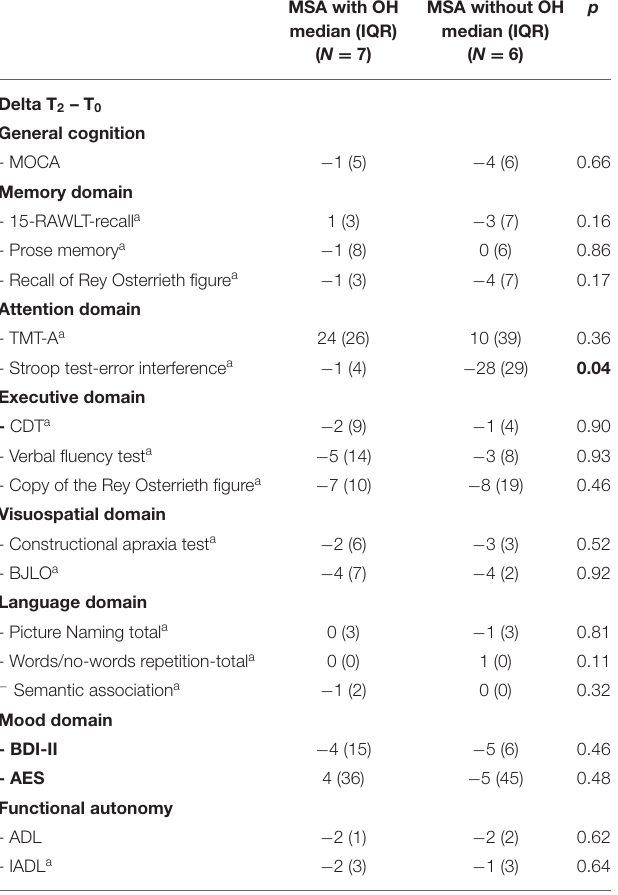
TABLE 3 | Changes in neuropsychological tests between MSA patients with and without OH at T 2